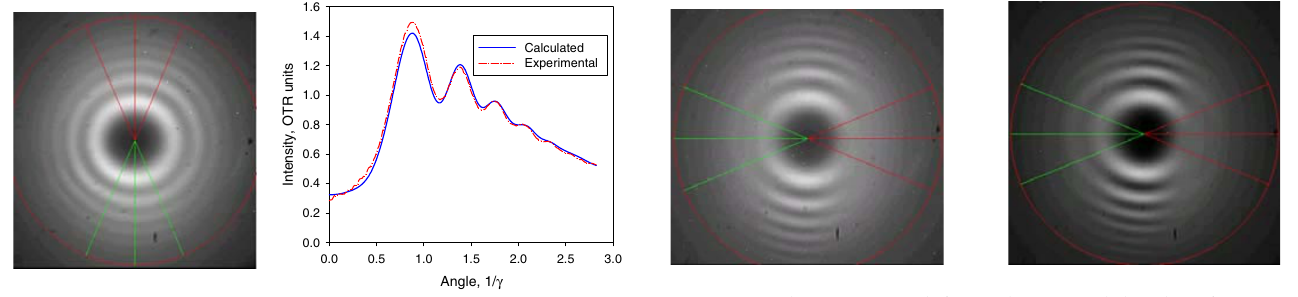
FIG. 12. (Color) ODTRI pattern (left) and sector average verti- cal line scans